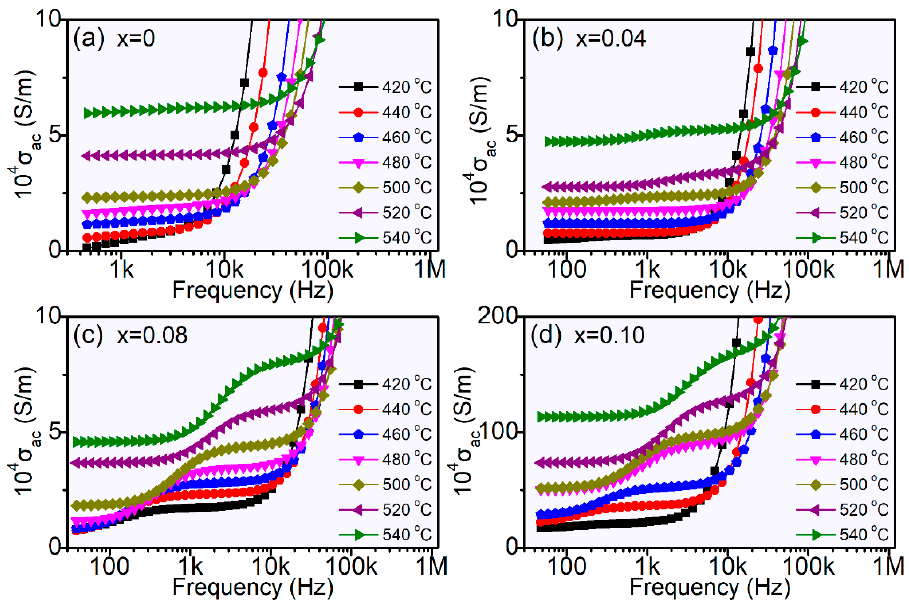
Figure 9. Frequency/temperature-dependent normalized imaginary parts of impedances for KNNS x -BNN ceramics with ( a ) x = 0, ( b ) x = 0.04, ( c ) x = 0.08 and ( d ) x = 0.10 measured at high temperature.